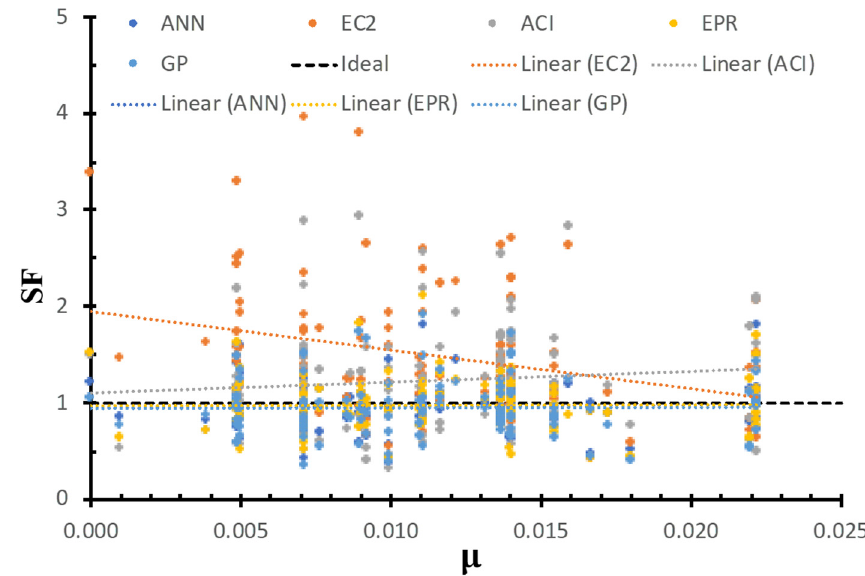
Figure 12. SF calculated using various models versus µ